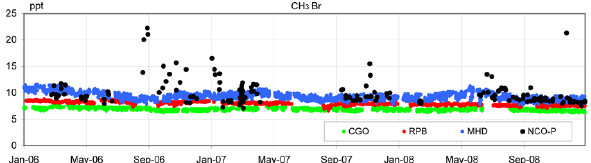
Fig. 7. CH 3 Br measured at NCO-P (all data) compared with base- line data at at MHD (blue), RPB (red) and CGO